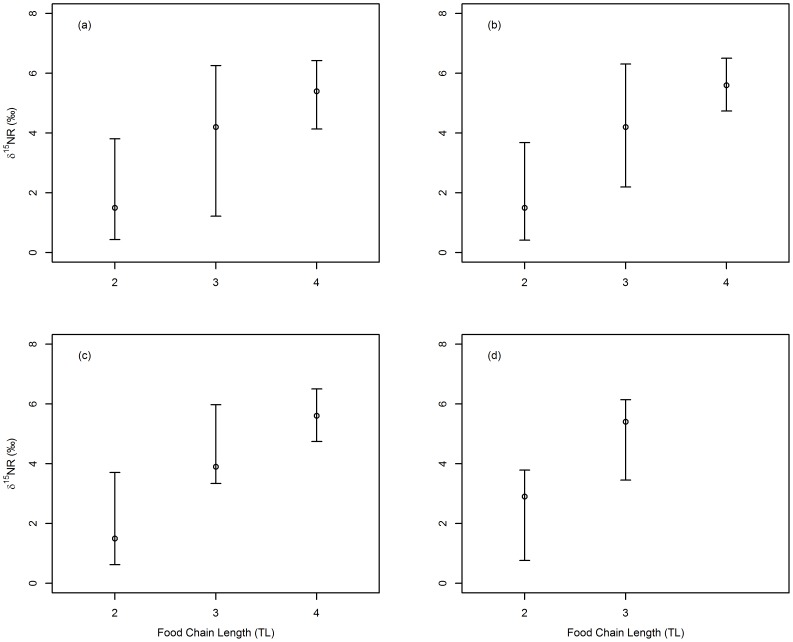
Overall nitrogen range (NR) for food chains containing two, three or four trophic levels.Values derived from combining resampled mean values from all four replicate food chains. TL  =  trophic levels. Circles represent mode (of means) and bars 95% credible intervals for mean. a) all combinations: 2 TL n = 10, 3 TL n = 7, 4 TL n = 3; b) excludes combinations that include wheat plants: 2 TL n = 9, 3 TL n = 5, 4 TL n = 1; c) excludes all combinations that include wheat or maize plants: 2 TL n = 8, 3 TL n = 4, 4 TL n = 1; d) excludes all combinations containing primary producers: 2 TL n = 7, 3 TL = 3.